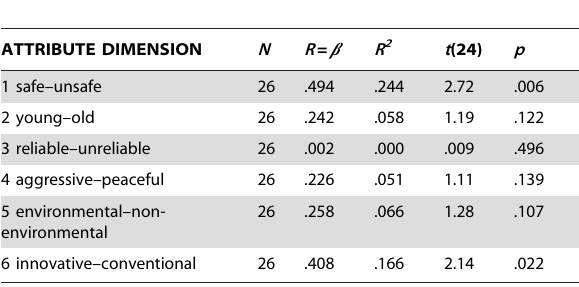
Table 5. Study 1: Estimates of convergent validity (simple linear regressions for all six dimensions).